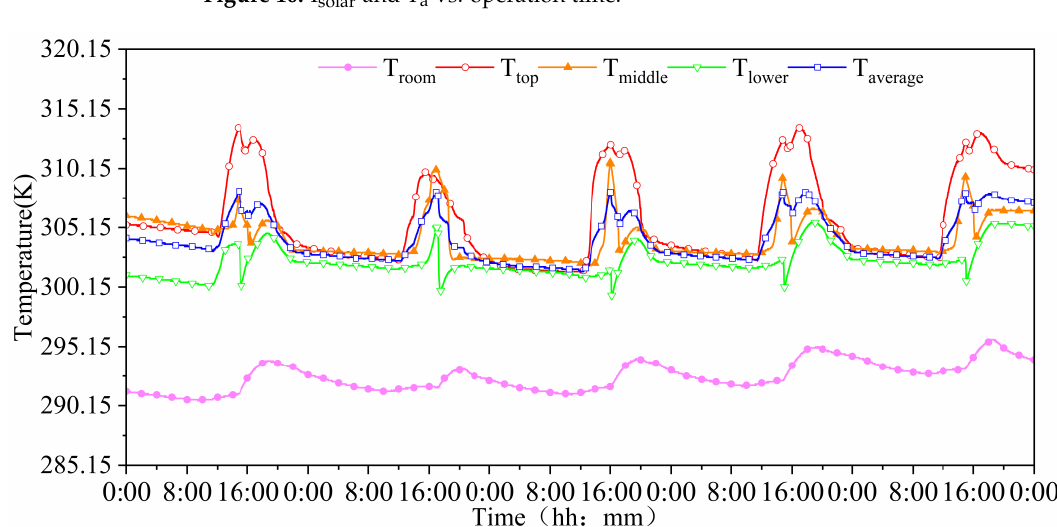
solar and T a vs. operation time.